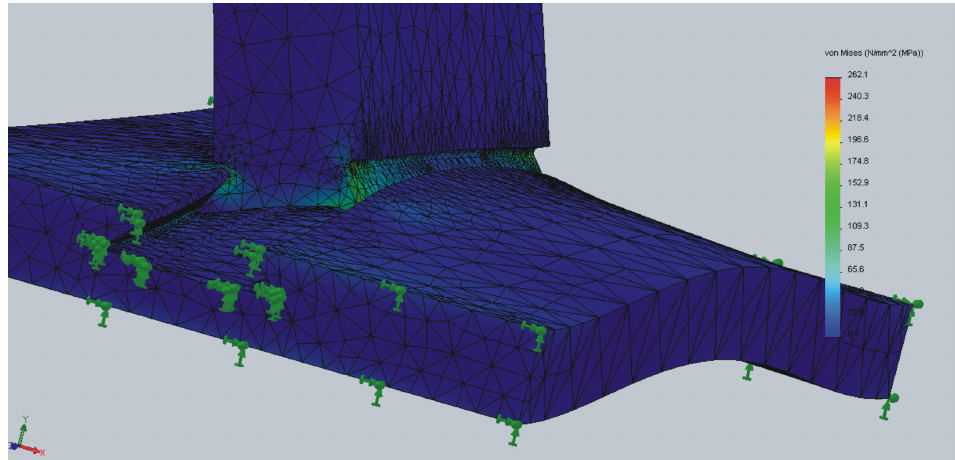
Figure 15: FEM analysis of the base - pole piece joined by a dovetail coupling.